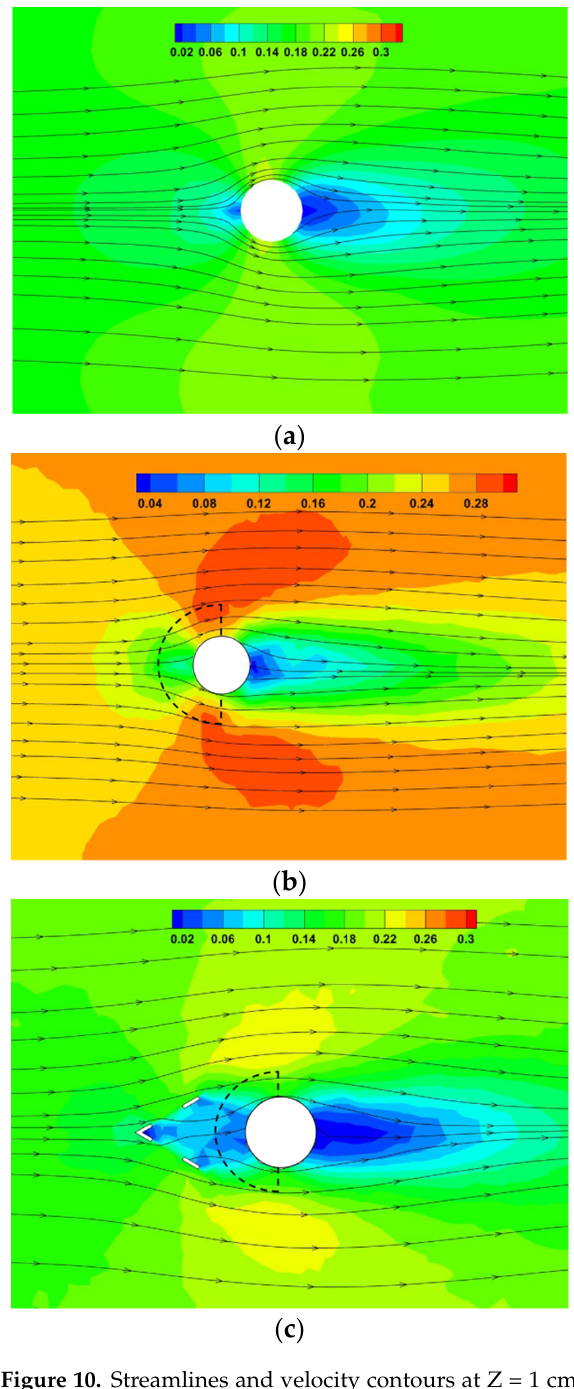
Figure 10. Streamlines and velocity contours at Z = 1 cm. ( a ) Single pier; ( b ) Pier with ring-wing plate; ( c ) Pier with combined device.